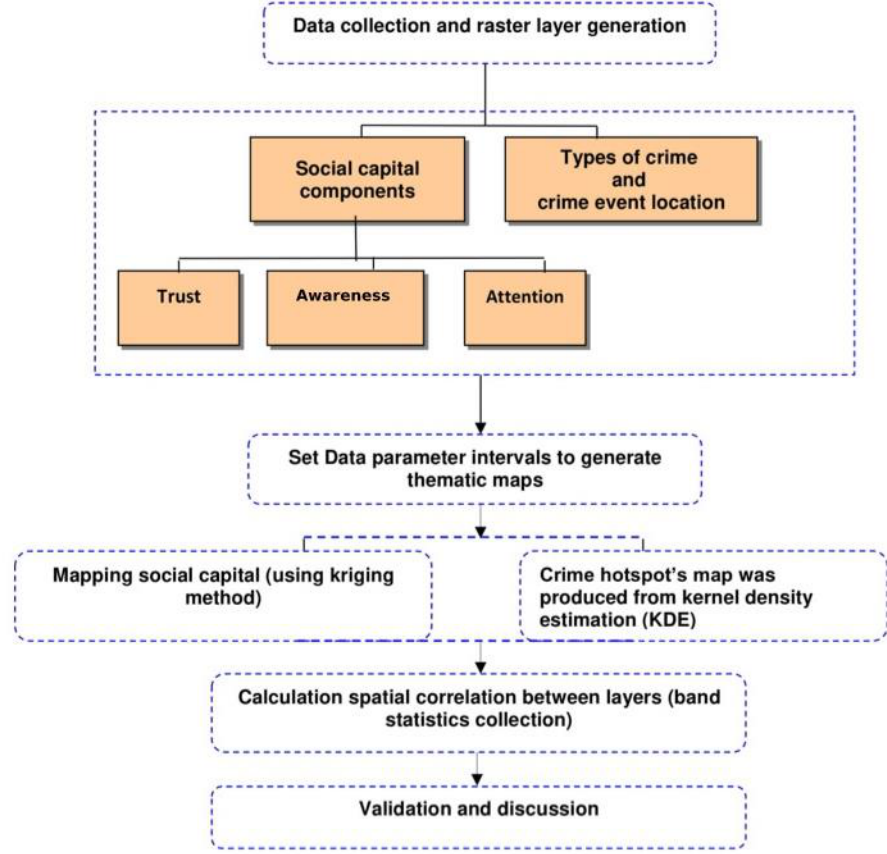
Fig. 1. The process of GIS